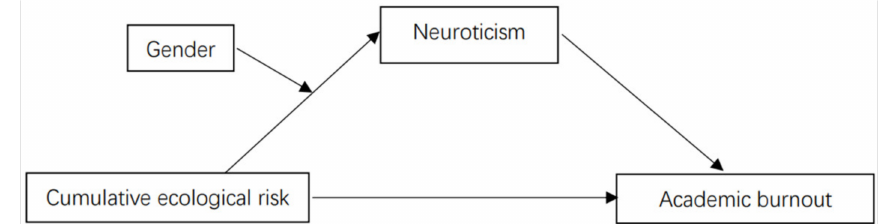
Figure 1. The proposed moderated mediation